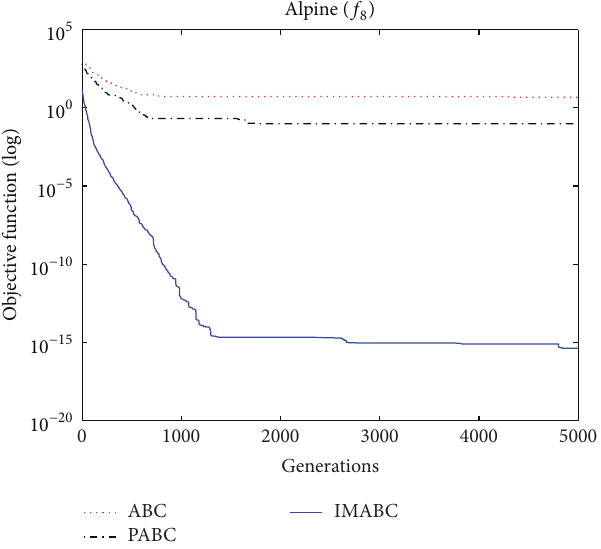
Figure 10: 𝑓 8 function convergence performance comparison.